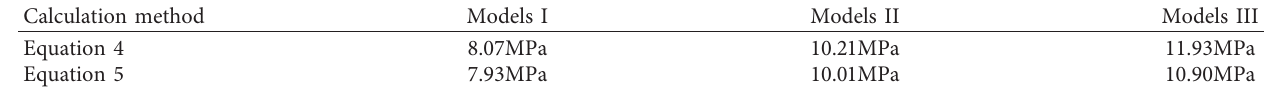
Table 2: Calculation results of tensile strength by different calculation